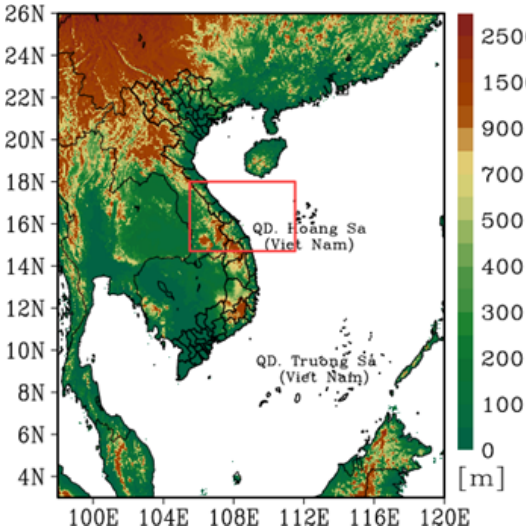
Figure 2. The simulation domain of the CReSS model and topog- raphy (m) used in this study. The red box marks the study